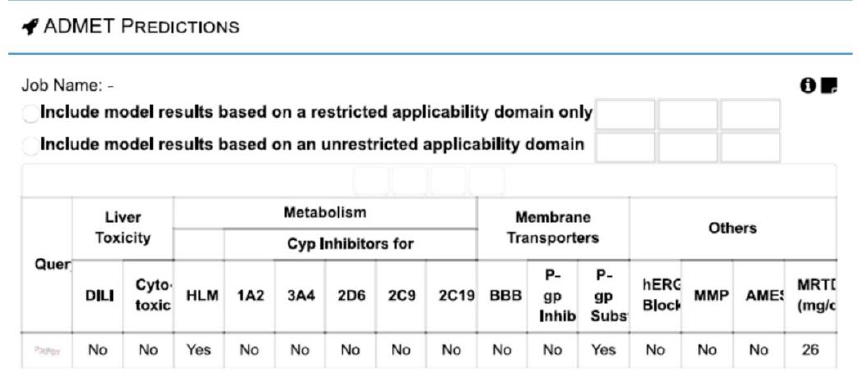
Figure 5. vNN-ADMET predicts SAICAR as a substrate of drug transporter P-gp and no adverse cell toxicity.